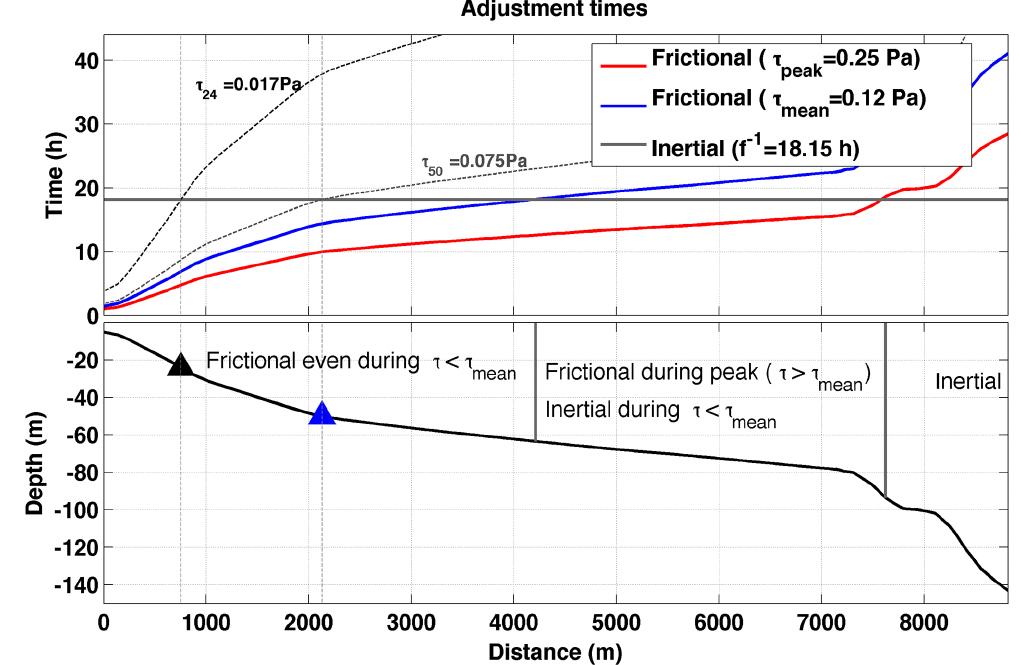
Figure 8. (Top panel) cross-shelf transect of the frictional adjustment times for several along-shelf wind stresses (τ) together with the inertial time off the city of Barcelona (18.15h, grey solid line). The cross-shelf variation of the frictional adjustment time (computed following Eq. 8) is shown for storm peak conditions (red line) and averaged storm conditions (blue line). The two dotted lines correspond to wind stresses such that the frictional and inertial times become equal at 24m ( t 24 ) and 50m ( t 50 ) water depth. (Bottom panel) the location of the inertial, frictional and transition zones for the peak and mean storm conditions. The ADCP locations at 24m and 50m are indicated with black and blue triangles,